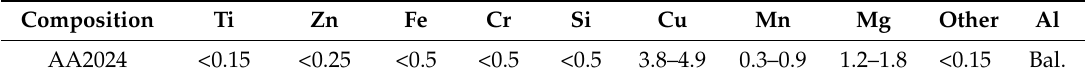
Table 1. Chemical composition of AA2024 alloy.